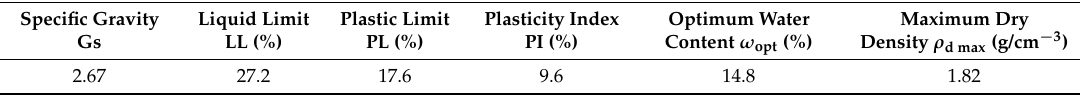
Table 1. Physical properties of the test loess